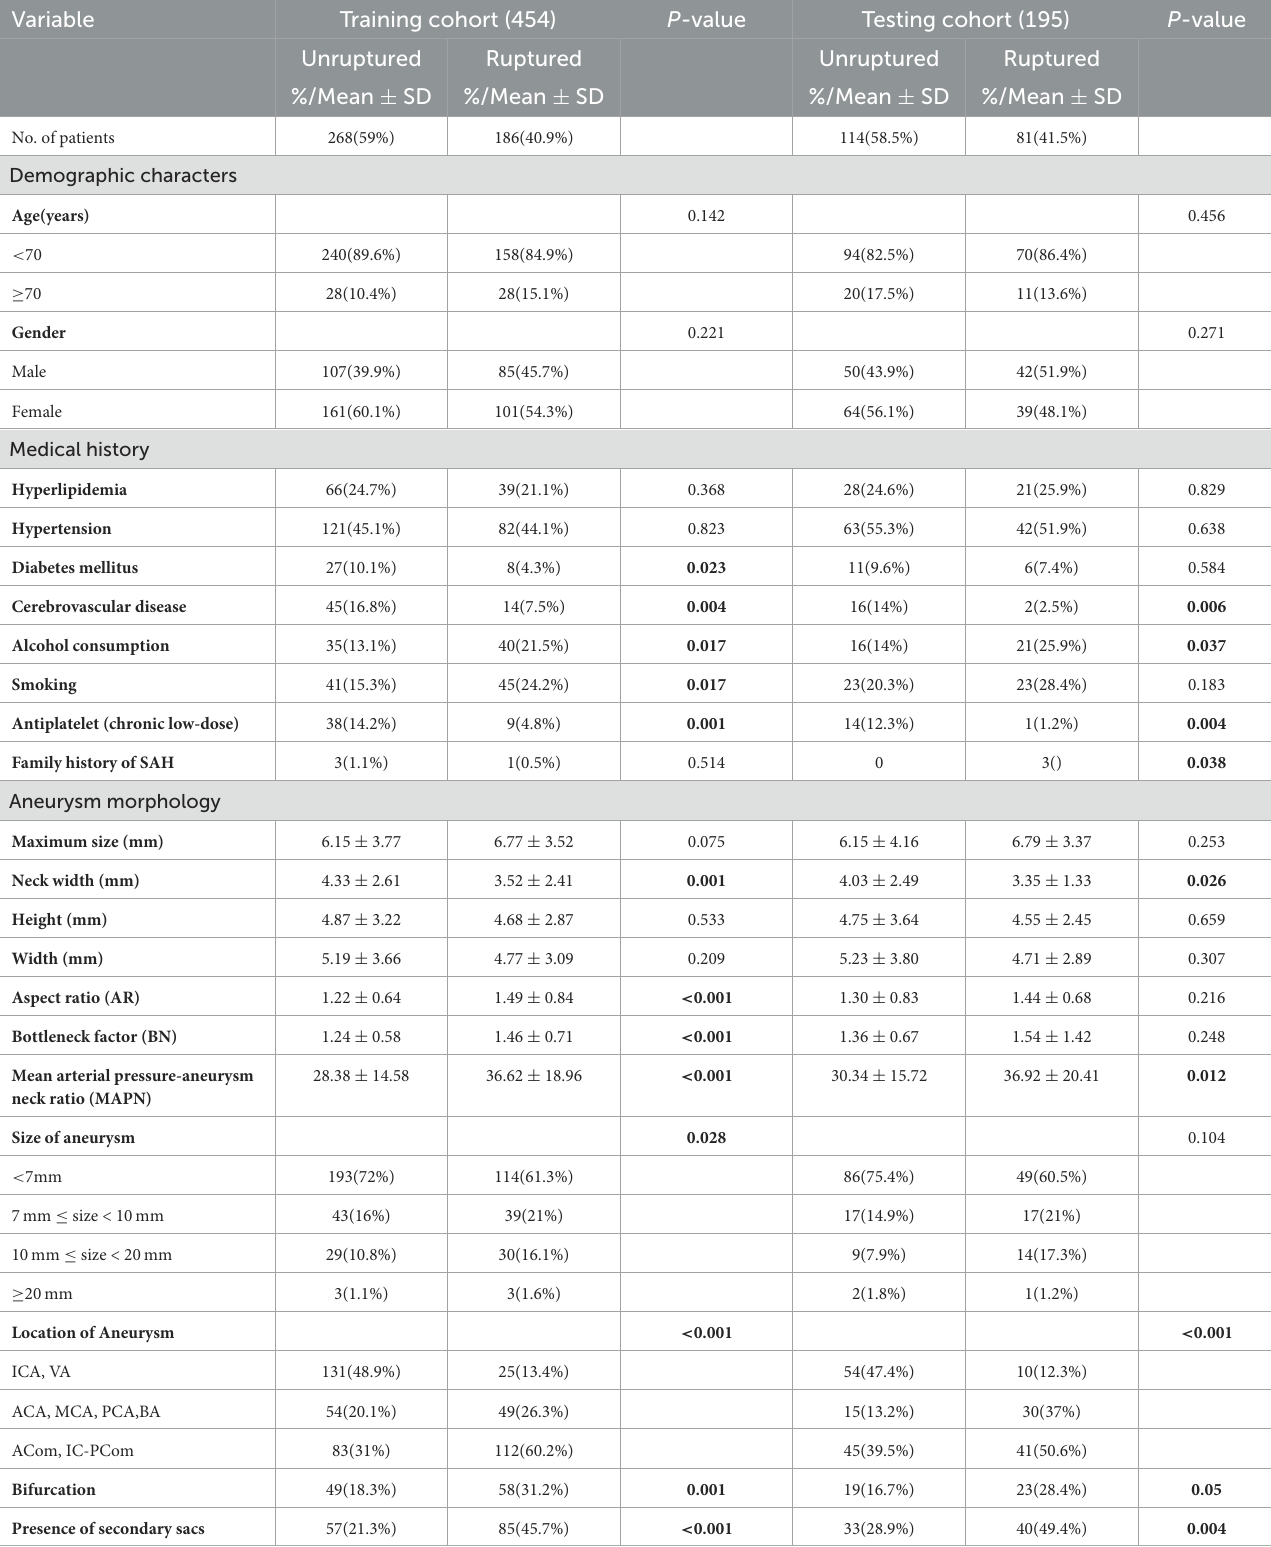
TABLE 1 Baseline characteristics and aneurysm morphology of study